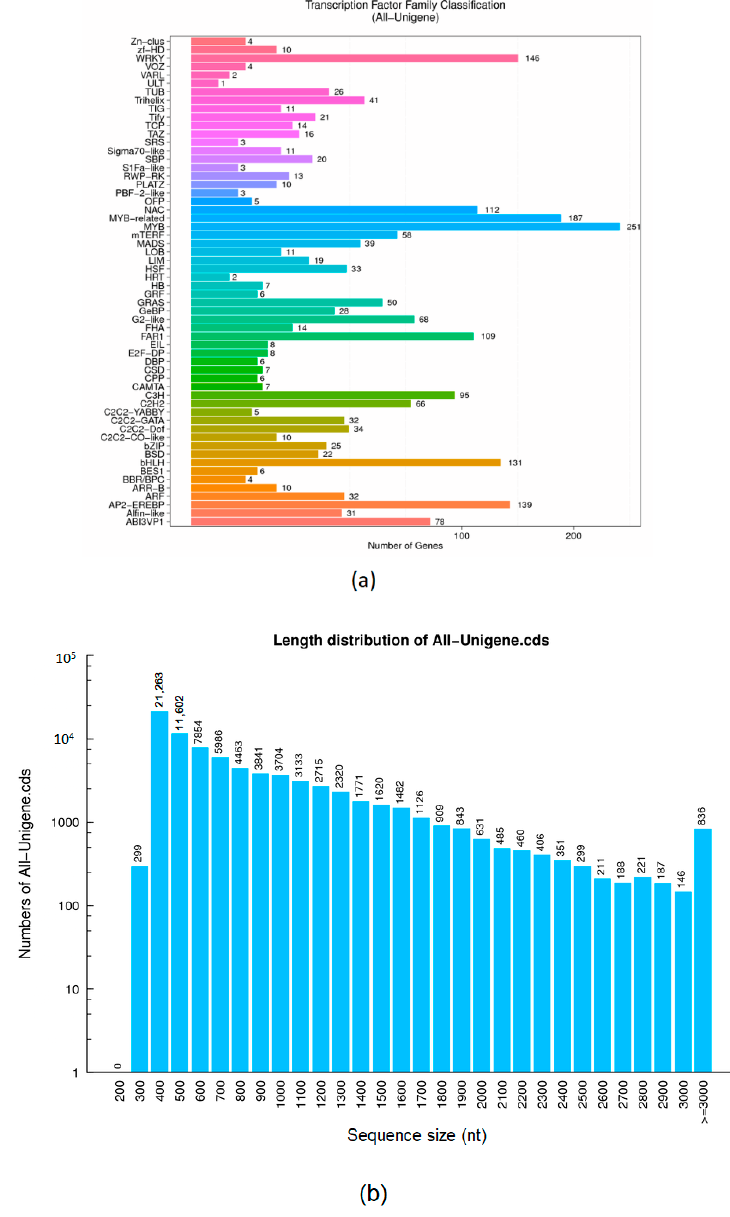
Figure 3. Bar plots showing the distribution of ( a ) Transcription factors. The X -axis represents the corresponding number of unigenes, and the Y -axis represents the transcription factor family classification. ( b ) Coding DNA sequence (CDS) length. The X -axis represents the length of the CDS, and the Y -axis represents the corresponding number of CDSs.